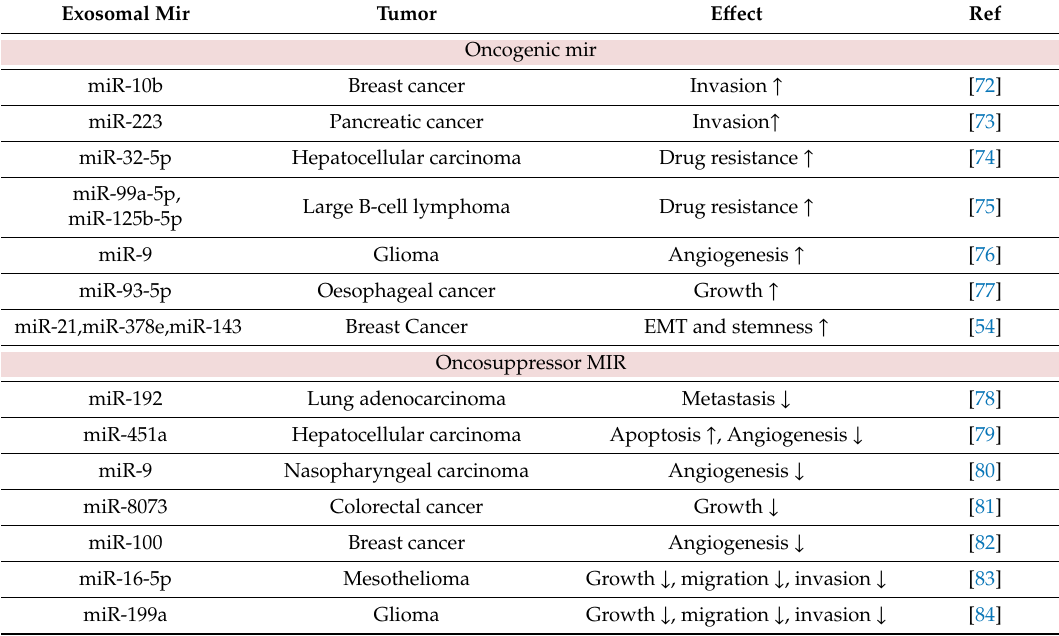
Table 1. Oncogenic and Oncosuppressor exo-miRNAs and their roles in cancer progression. ↑ means Increase, ↓ means